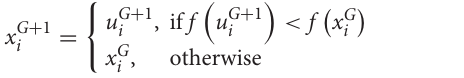
Frontiers in Materials |